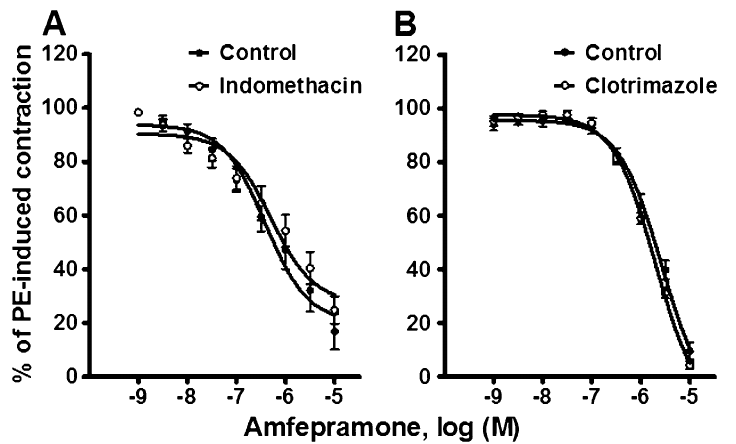
Figure 5. Effects of 10 –5 M indomethacin ( A ) and 10 –5 M clotrimazole ( B ) on amfepramone- induced vasorelaxation in rat aortic rings with functional endothelium and precontracted with 10 –6 M phenylephrine (PE). Data are reported as means±SE of n=6 observations. P . 0.05 vs control (two-way repeated-measures